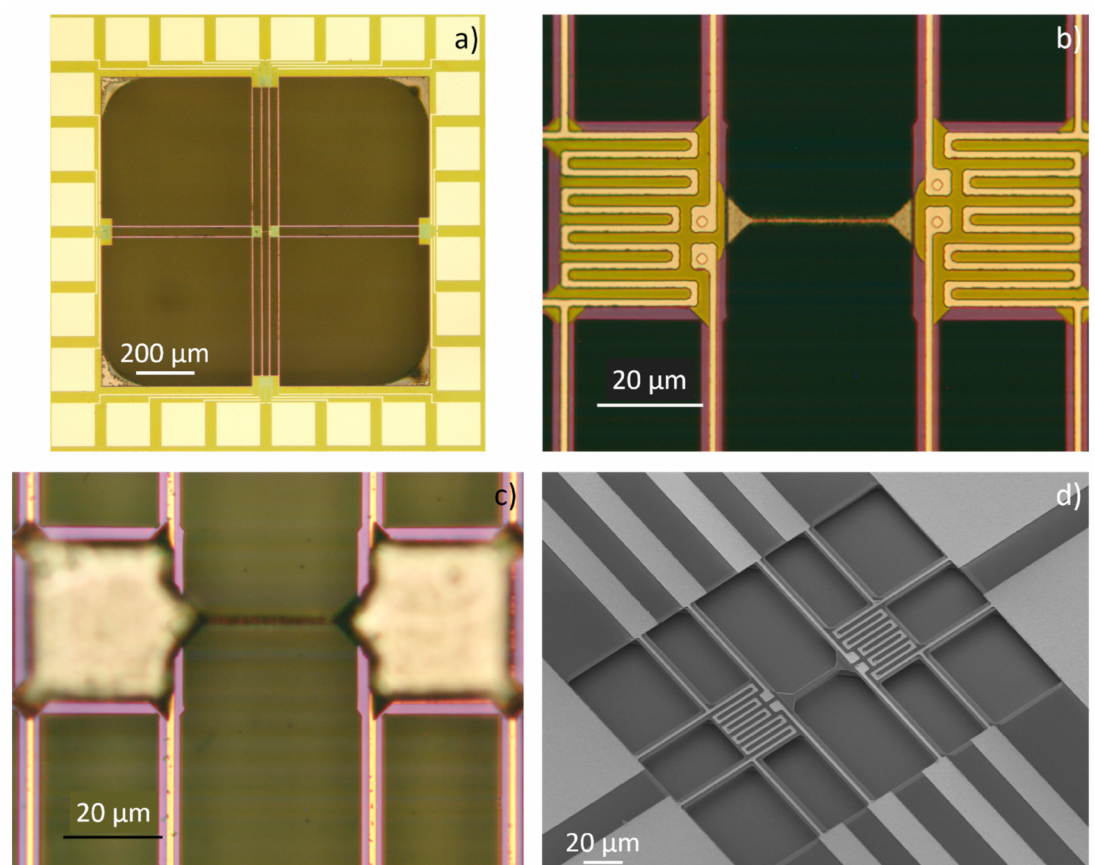
Figure 4. ( a ) General top view of a suspended device manufactured from an SOI wafer. ( b ) Platforms with a silicon beam between them, after removing the silicon under the supporting SiN/Pt bridges with KOH. ( c ) Back-side view of the platforms indicating successful removal of silicon. ( d ) General top view of a “small” device with shorter supporting beams after BOX layer and KOH etching (no stiction was